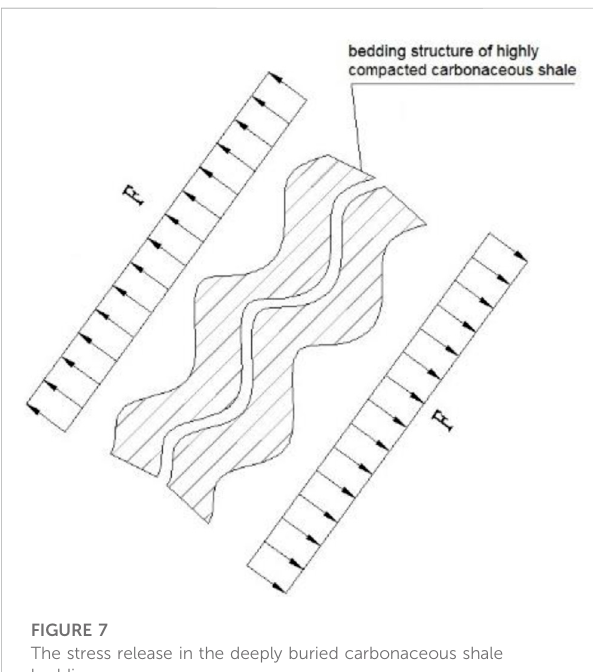
FIGURE 7 The stress release in the deeply buried carbonaceous shale bedding.